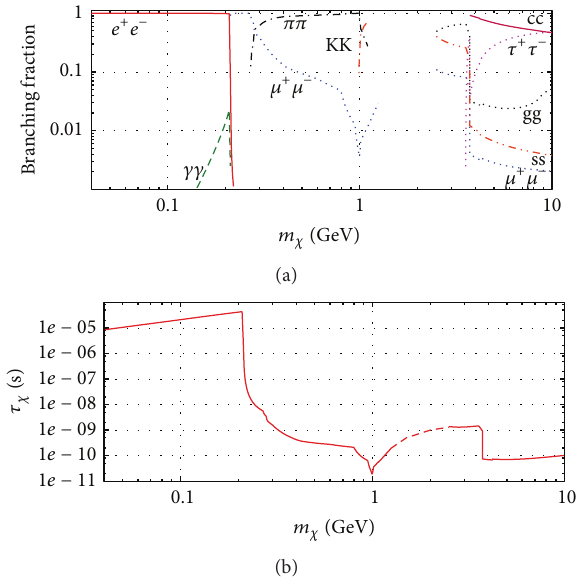
Figure 1: Predictions from [4]. (a) Inflaton branching ratios to various two-body final states as functions of inflaton mass for 𝑚 𝜒 < 1.5 GeV. Above 2.5 GeV only quark-antiquark and dilepton modes are predicted. In the intermediate region no reliable prediction is given. (b) Inflaton lifetime 𝜏 𝜒 as a function of the inflaton mass 𝑚 𝜒 . The lifetime can be up to two times smaller, depending on model- dependent